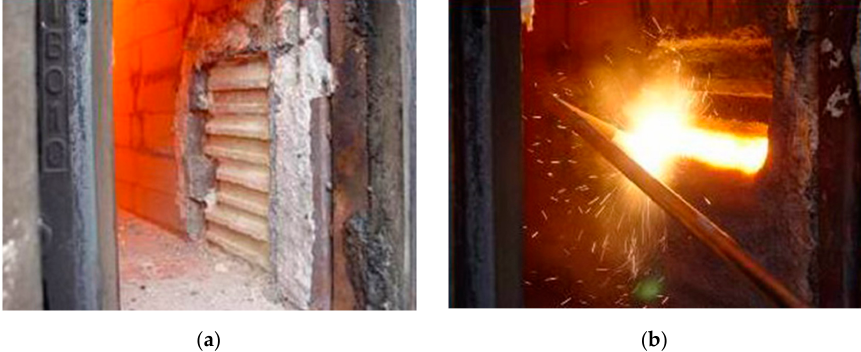
Figure 5. ( a ) Repair by fused silica pieces; ( b ) ceramic welding on refractory pieces.